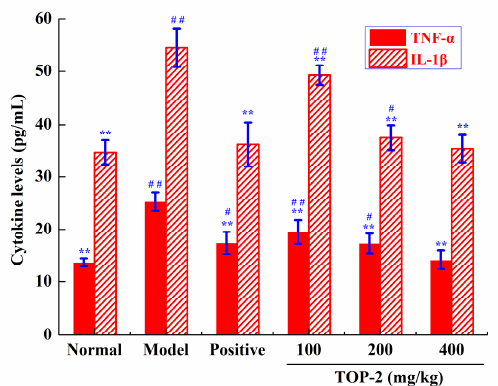
Figure 4. Effects of TOP-2 on liver TNF- α and IL-1 β levels in alcohol-induced liver injury mice. Results are represented as means ± SD ( n = 10). ** p < 0.01, by contrast with model control; # p < 0.05 and ## p < 0.01, by contrast with normal control.